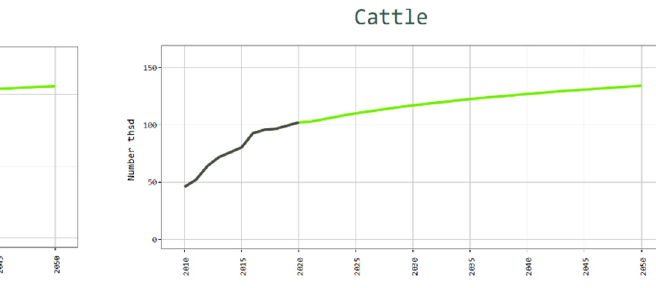
Figure 18. Arable land in organic farming in 2005–2020, with a 2021–2050 projection for Latvia, in thousands of hectares [62].